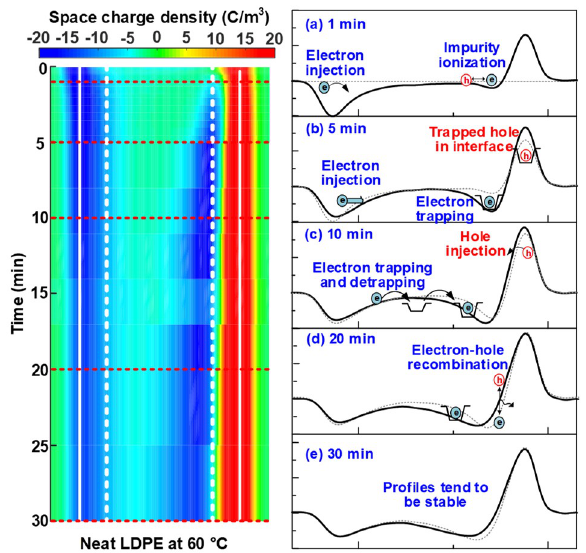
Figure 4. Space charge dynamic behaviors in the neat LDPE sample under +30 kV/mm at 60 °C. The polarization time is ( a ) 1 min, ( b ) 5 min, ( c ) 10 min, ( d ) 20 min and ( e ) 30 min, respectively.